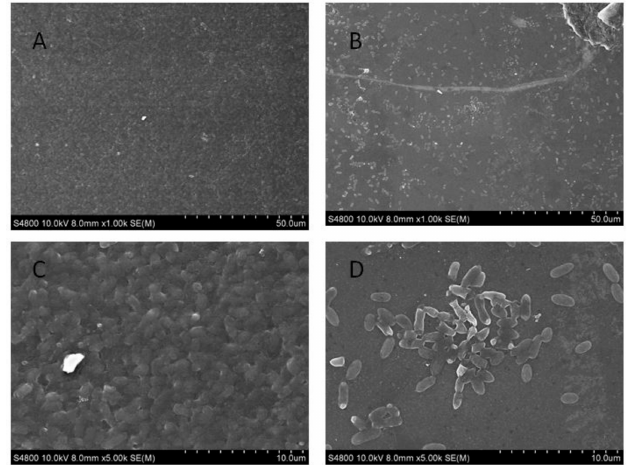
Figure 3. Scanning electron microscopy used to observe Aeromonas veronii TH0426 biofilm formation. ( A ) biofilm state bacteria ( × 1000); ( B ) planktonic state bacteria ( × 1000); ( C ) biofilm state bacteria ( × 5000);